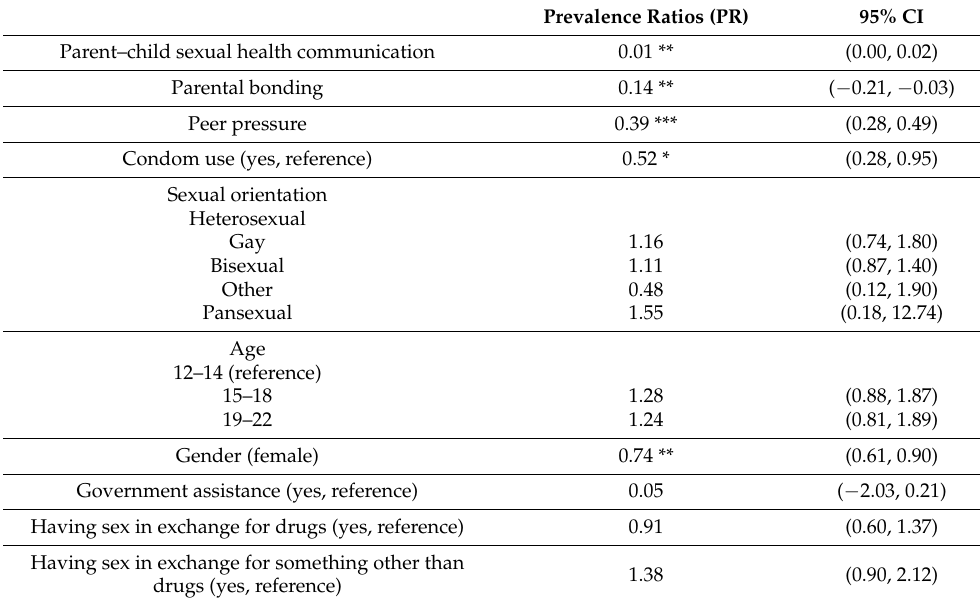
Table 4. Estimated prevalence ratio for drug use among Black youth ( N = 340).